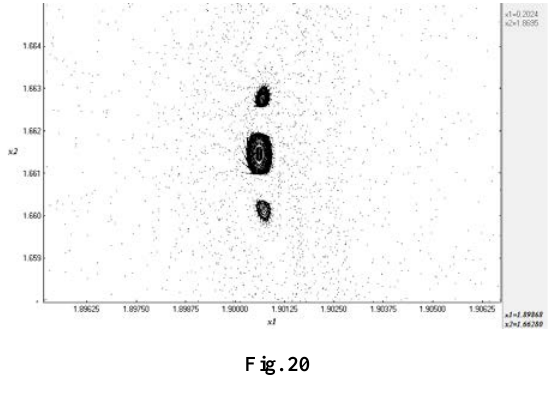
In this work, we examined the Laskar model of the moonless Earth. Special segments of the non- autonomous Laskar system with singular points of the "center" type were found. The evolutions of the inclination and longitude of the axis of rotation over the years are obtained. interval Three chaotic regions of the evolution of inclination 7 10 on the axis of the initial inclination parameter are found. The bifurcation diagrams of the system of the . Plots system are constructed for various parameters 0T of the Lyapunov exponent and the averaged MEGNO 𝛼𝛼 , 𝜖𝜖 exponent are plotted depending on the initial inclination. A stroboscopic Poincare mapping corresponding to a chaotic attractor is constructed. The presence of a chaotic attractor explains the absence of catastrophic climate changes in the chaotic region of the evolution of